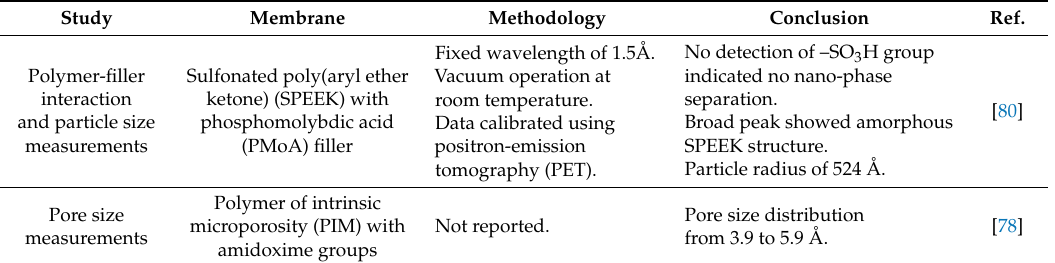
Figure 18. SAXS analysis of sulfonated poly(aryl ether ketone) (SPEEK)/phosphomolybdic acid (PMoA) membranes (a), and pristine SPEEK membranes (b) [80].